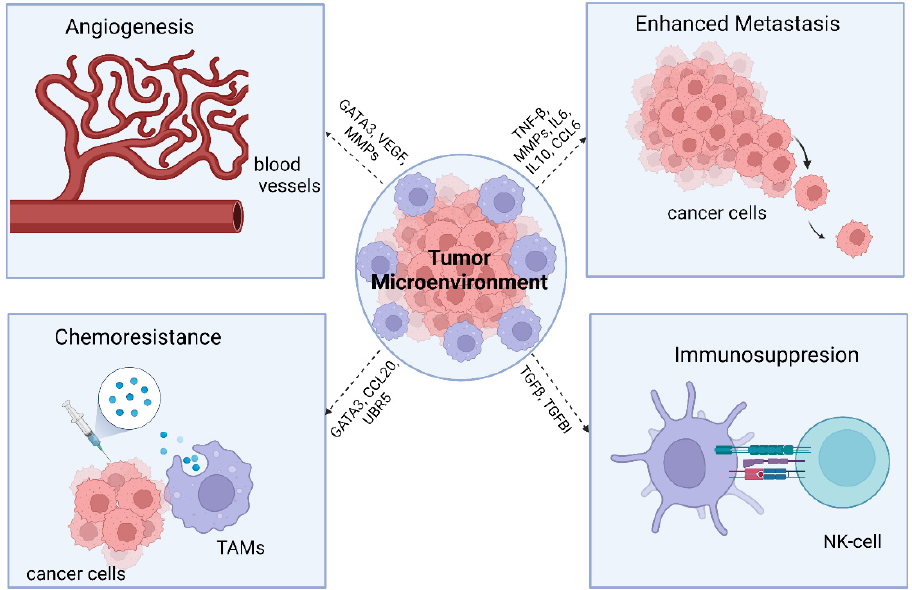
Figure 2. Roles of macrophages within the tumor microenvironment that enhance the progression of malignancy. Created with BioRender.com. Accessed on 21 April 2022.